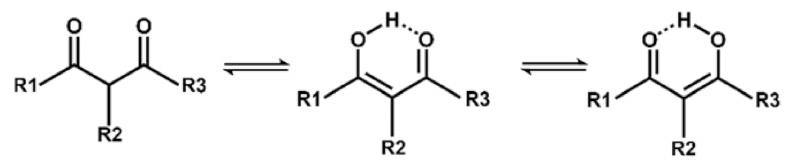
Figure 1. Keto-enol tautomerization in β